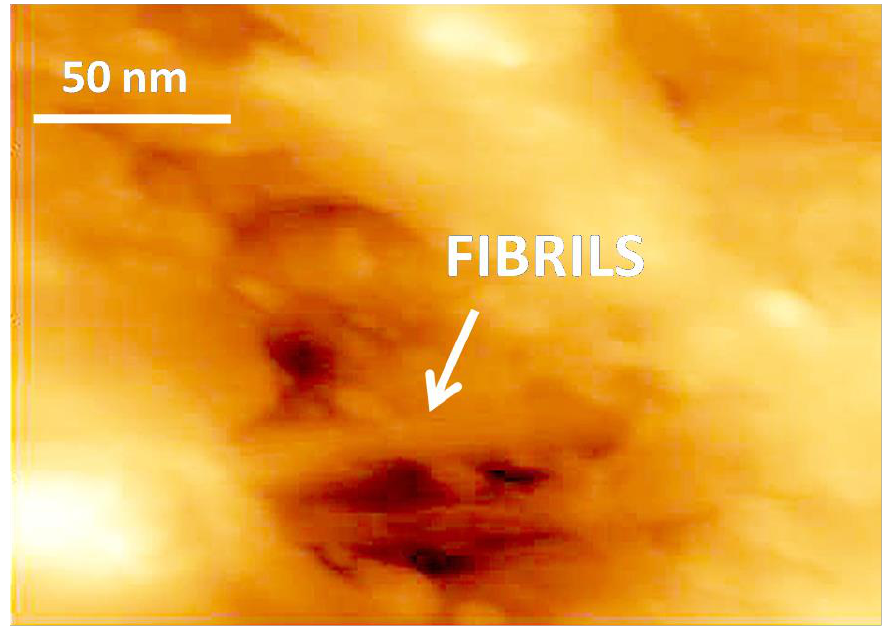
Figure 5. AFM image of the UHMWPE film after tensile drawing in the PALE (O/W emulsion based on n -heptane and water, 95 vol. % of water) by tensile strain ε = 250%.